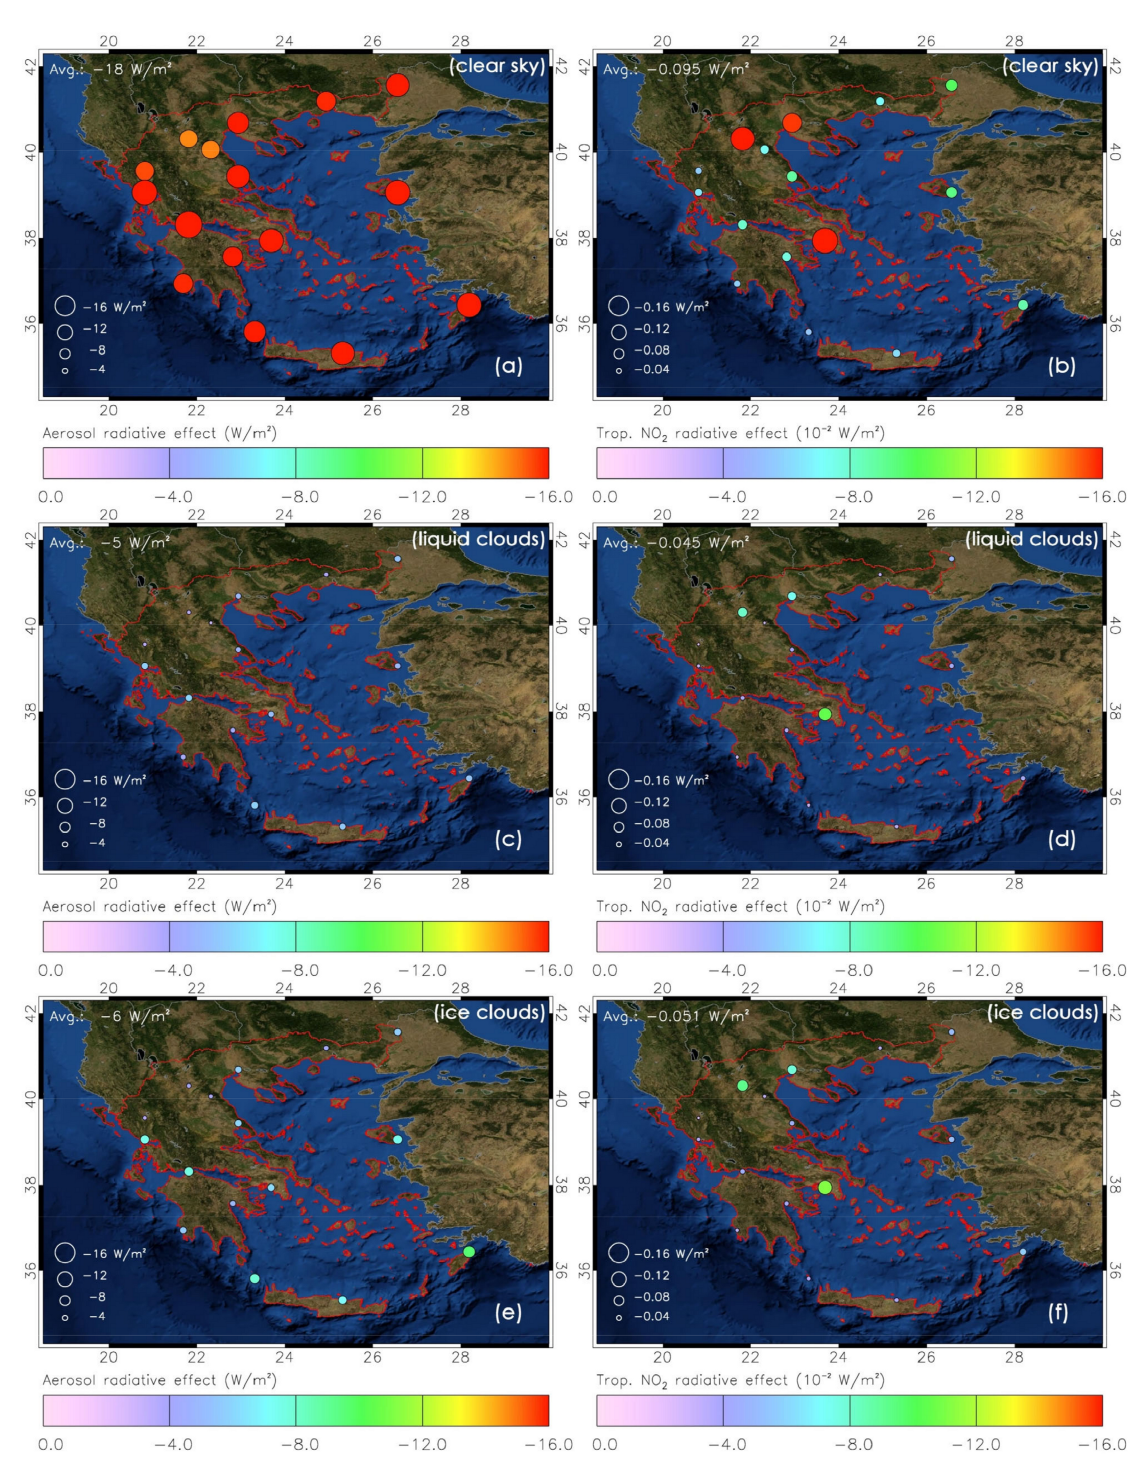
Figure 6. Annual average radiative effect of aerosols and tropospheric NO 2 for ( a , b ) clear, ( c , d ) liquid and ( e , f ) ice cloud- covered skies over 16 locations in Greece for the period 2005–2019. Mind that a different scale is used for the two parameters and that the radiative effect of tropospheric NO 2 is smaller by two orders of